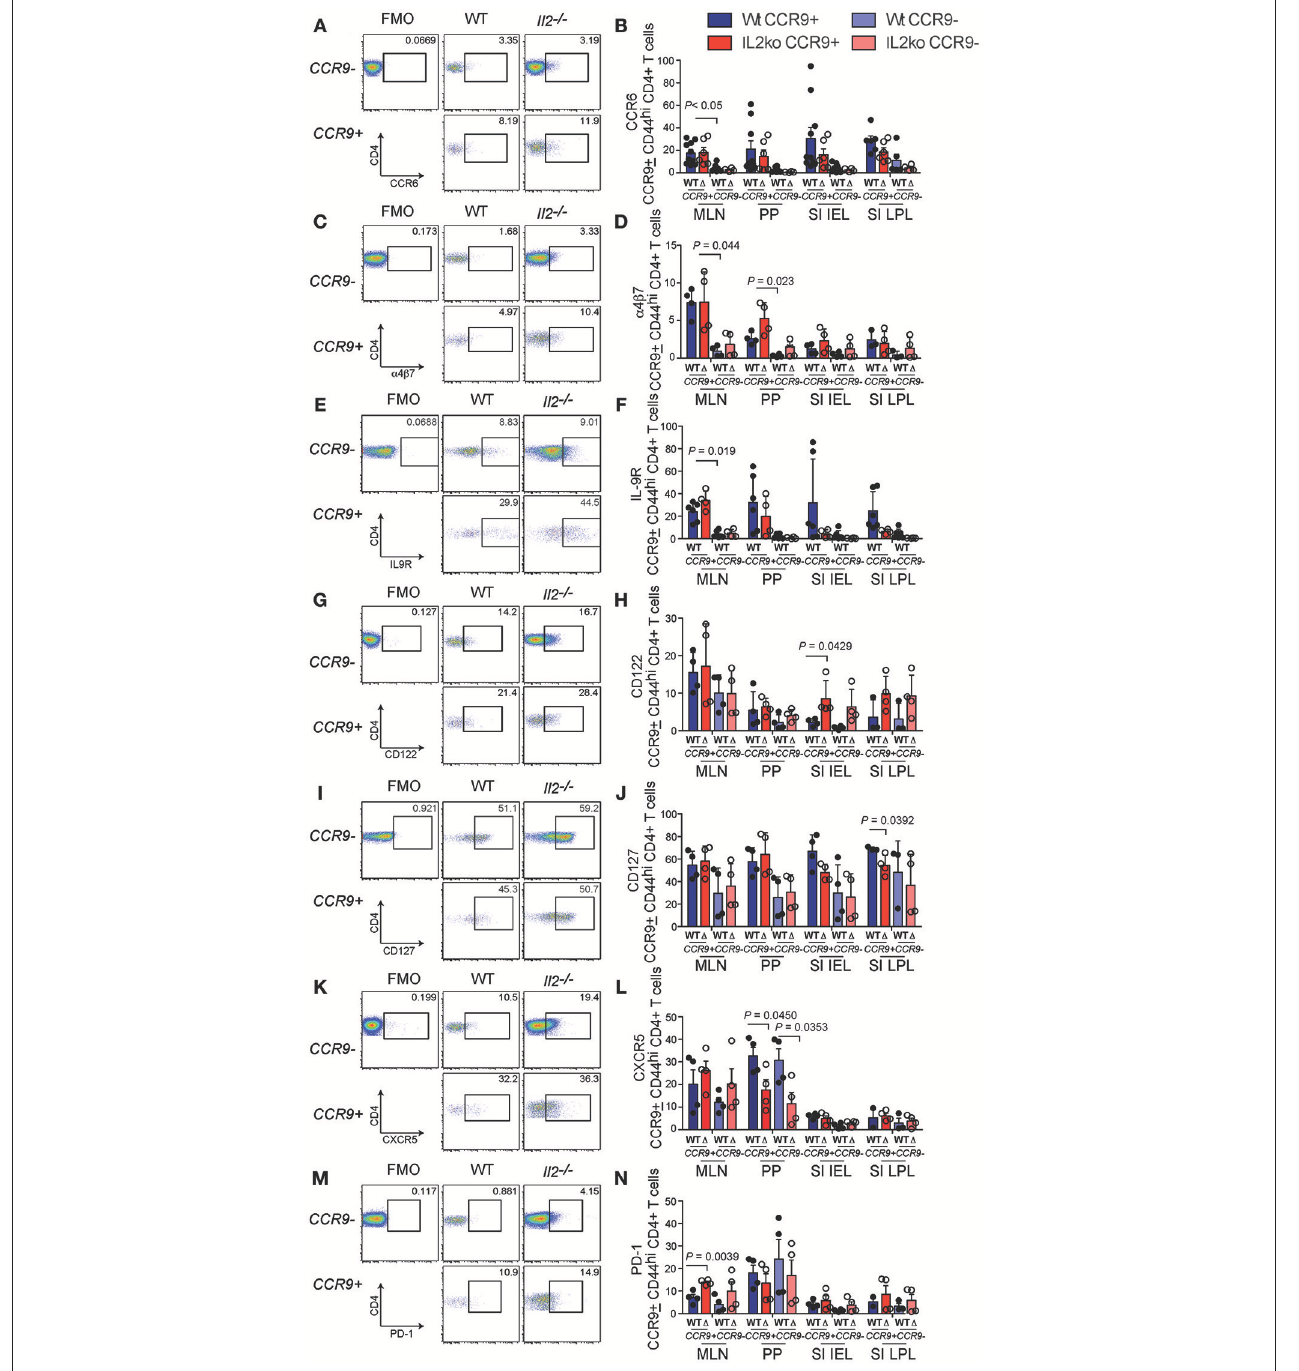
FIGURE 3 | Distinct phenotypic profile of CCR9+ Th cells in the inflamed GIT. Flow cytometric analyses showing representative FACS dot plots of surface marker expression for CCR9 + and CCR9 − CD44 hi CD4 + T cells from the mesenteric lymph nodes and quantitation of the percentages of CCR9 + and CCR9 − CD44 hi CCD4 + T cells from Il2 − / − and WT mice. CCR6; (A) representative FACS dot plot and (B) quantitation. a4b7; (C) representative FACS dot plot and (D) quantitation. IL9R; (E) representative FACS dot plot and (F) quantitation. CD122; (G) representative FACS dot plot and (H) quantitation. CD127; (I) representative FACS dot plot and (J) quantitation. CXCR5; (K) representative FACS dot plot and (L) quantitation. PD1; (M) representative FACS dot plot and (N) quantitation. (MLN) mesenteric lymph nodes; (PP) Peyer’s Patches; (SI IEL) intraepithelial lymphocytes of the small intestine; (SI LPL) lamina propria lymphocytes of the small intestine; (LI IEL) intraepithelial lymphocytes of the large intestine; (LI LPL) lamina propria lymphocytes of the large intestine. Data shown as mean + SD, where n = 3-9 female mice at 7-9 weeks of age. Statistical significance was assessed by students T-test.